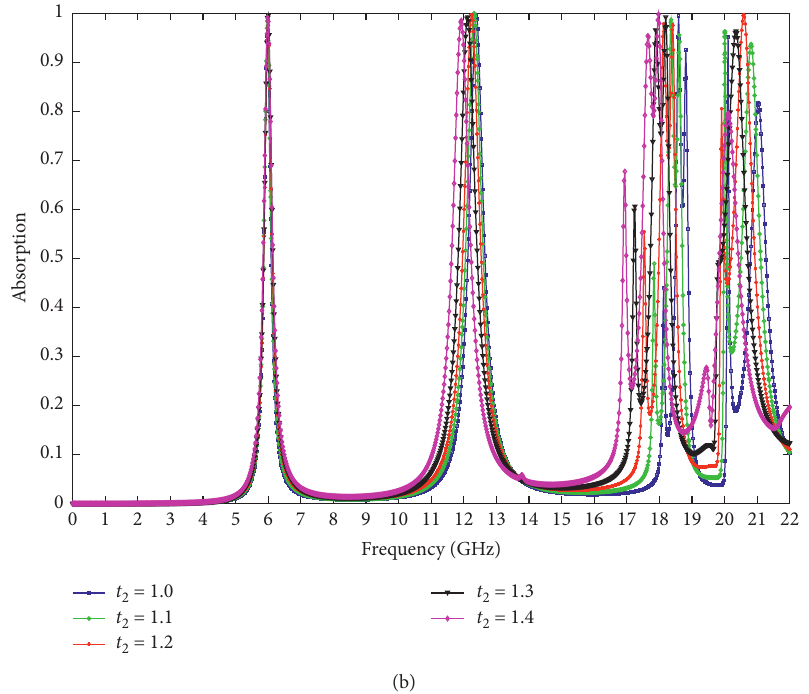
Figure 9: The effect of parameters on absorption: (a) different structure sizes m and (b) different dielectric layer thicknesses t